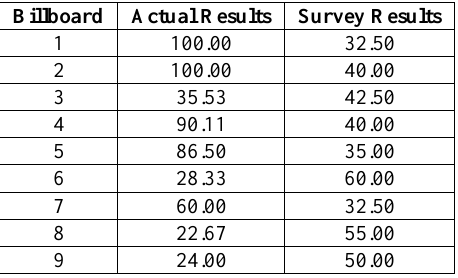
Table 5. Comparison of MLPV from analysis and